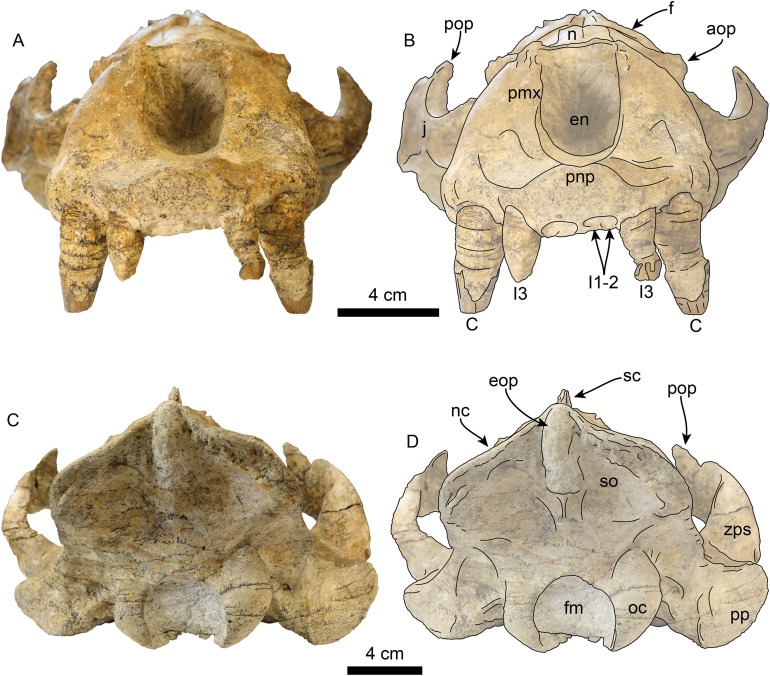
Skull of Titanotaria orangensis n. gen. et sp. (OCPC 11141).Skull in anterior (A–B), and posterior (C–D), views. Abbreviations: aop, antorbital process; C, upper canine; en, external nares; eop, external occipital protuberance; f, frontal; fm, foramen magnum; I1–3, upper incisors 1–3; j, jugal; n, nasal; nc, nuchal crest; oc, occipital condyle; pmx, premaxilla; pnp, prenarial process; pop, postorbital process; pp, paroccipital process; sc, sagittal crest; so, supraoccipital; zps, zygomatic process of squamosal.